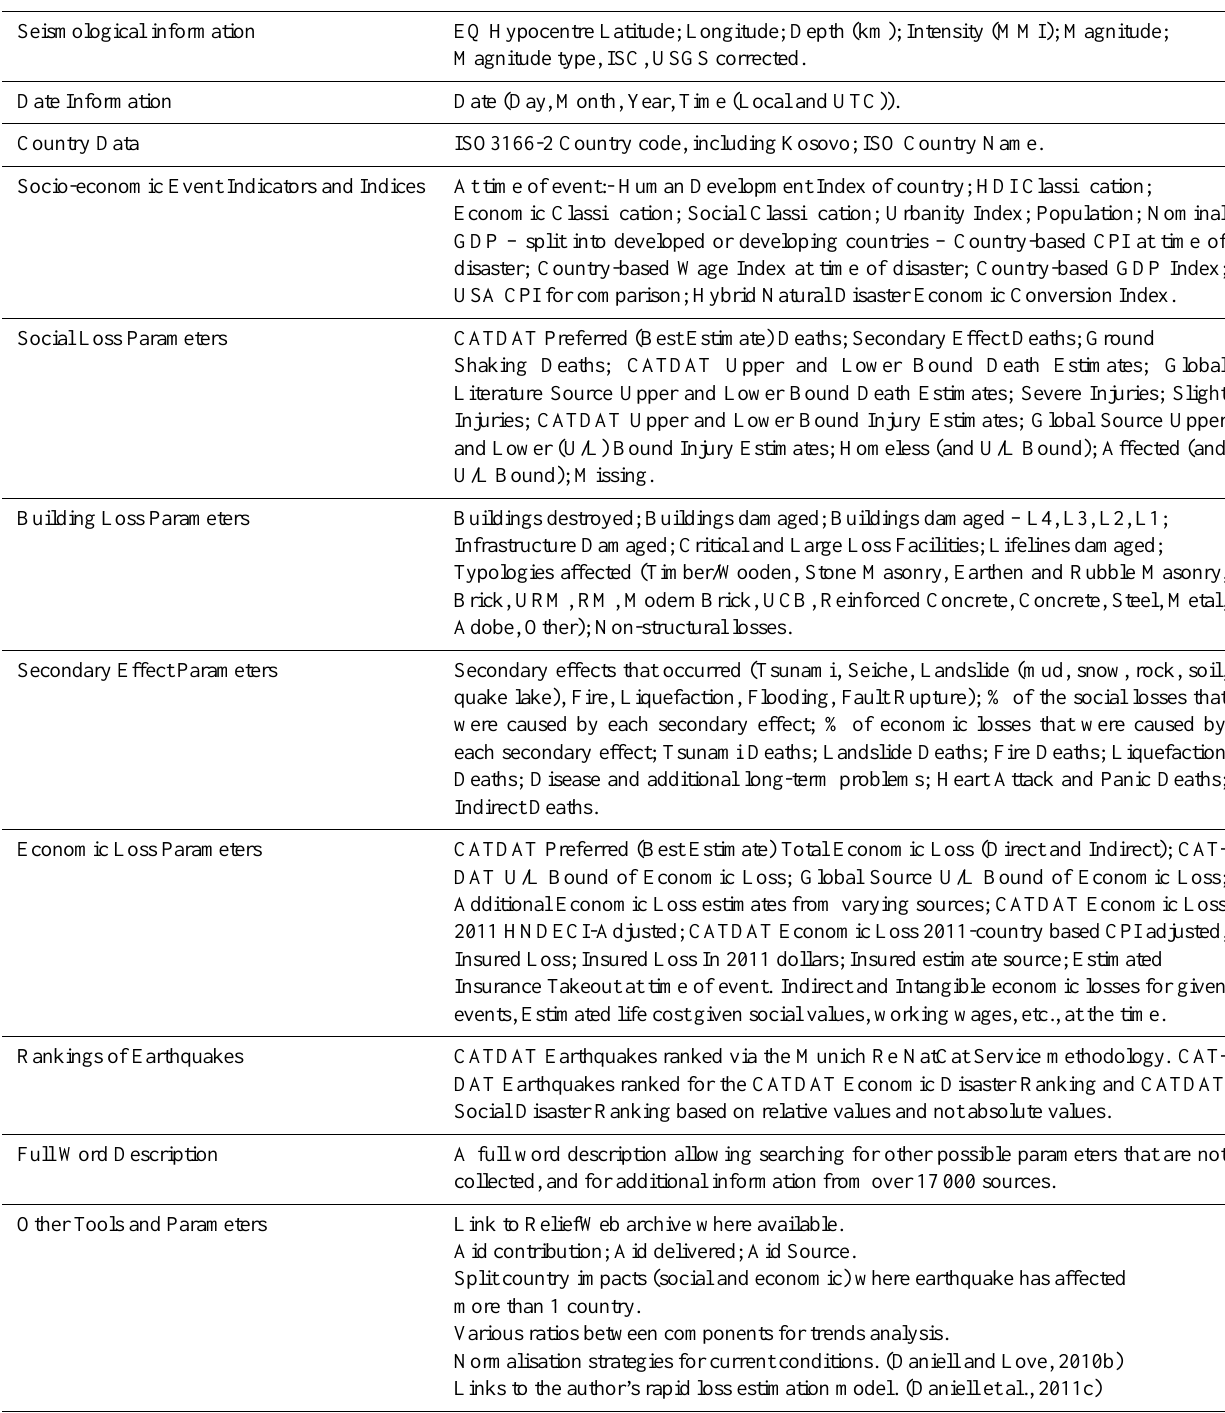
Table 1. Parameters in the CATDAT Damaging Earthquakes